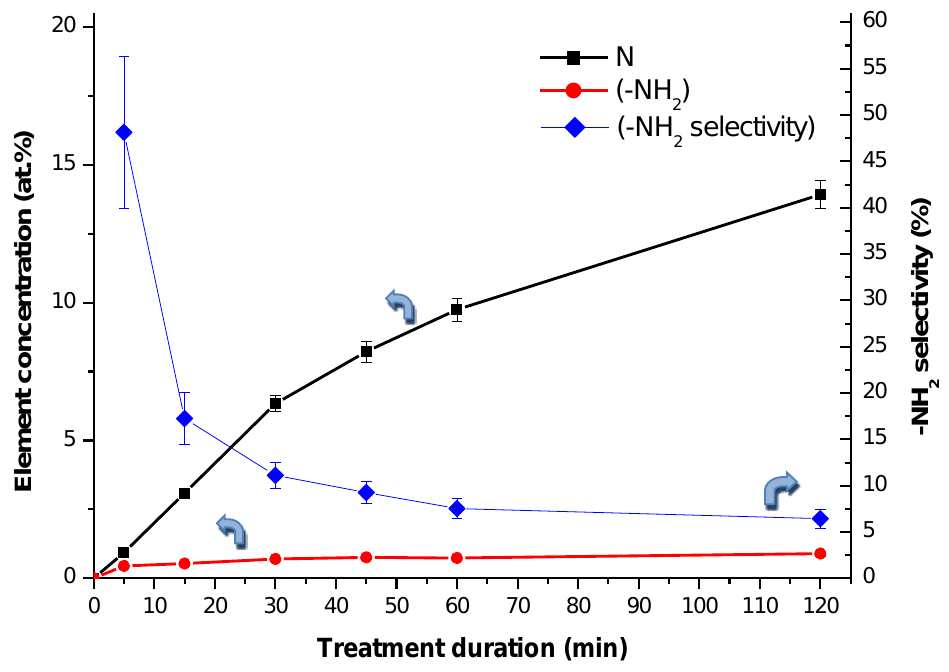
Figure 6. Evolution of nitrogen content and primary amines quantity and selectivity on CNT pellet with increasing treatment